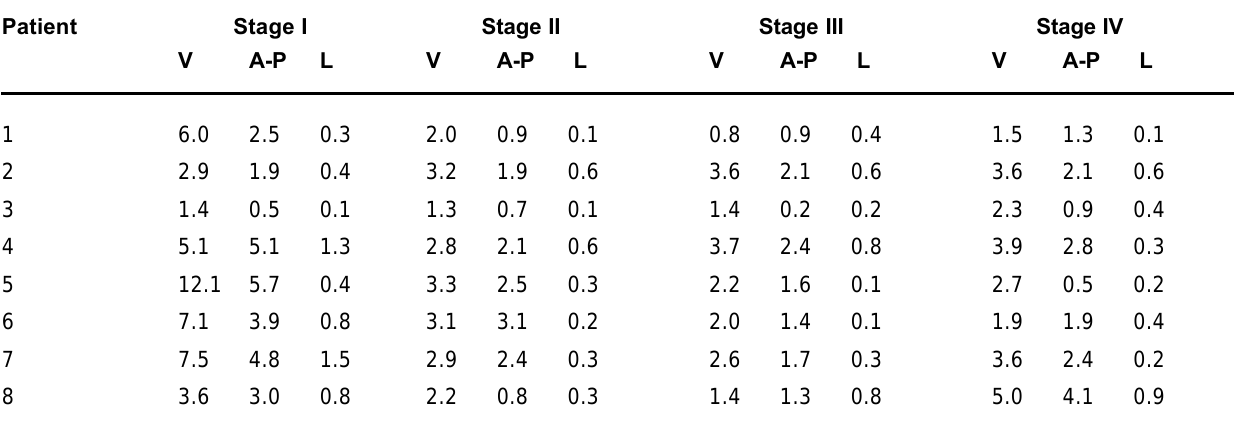
TABLE 7 - Mean vertical (V), anteroposterior (AP) and lateral (L) movement between rest position and intercuspal position (in millimeters) Patient